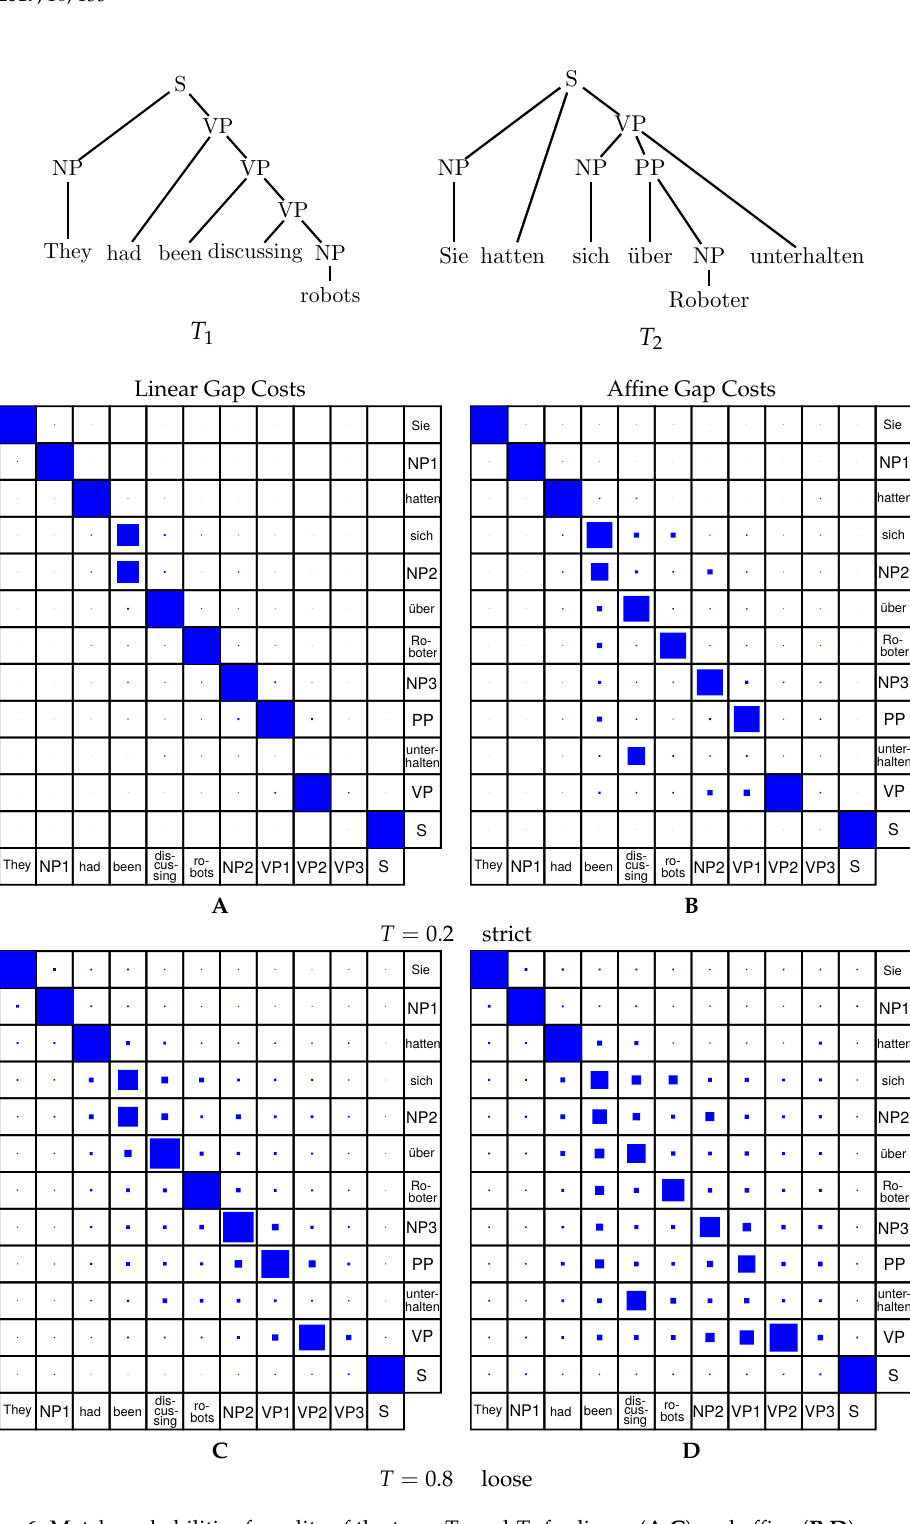
Figure 6. Match probabilities for edits of the trees T 1 and T 2 for linear ( A , C ) and affine ( B , D ) gap costs, and for two different choices of the scaling parameter T , 0.2 ( A , B ) and 0.8 ( C , D ). The size of the squares scales logarithmically with the probability as 1/ ( 1 − log p ) . The scores were set to − 2 for indels and mismatch, 2 for matches and − 1 for the affine gap costs in the affine case. The trees refer to syntax trees for a sentence in German ( T 2 ) and in English ( T 1 ) as depicted in the figure. In comparison to the tree alignment case, the labels of the trees’ nodes are in a slightly different order, as tree editing uses postorder while tree alignment is based on trees in